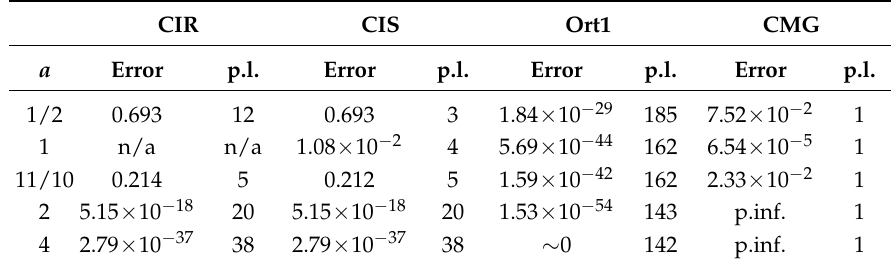
and precision loss for Polynomial(1/ t ) function, N = 64, T max = 32. Table 4. The error g g N (cid:107) − (cid:107) CIR CIS Ort1